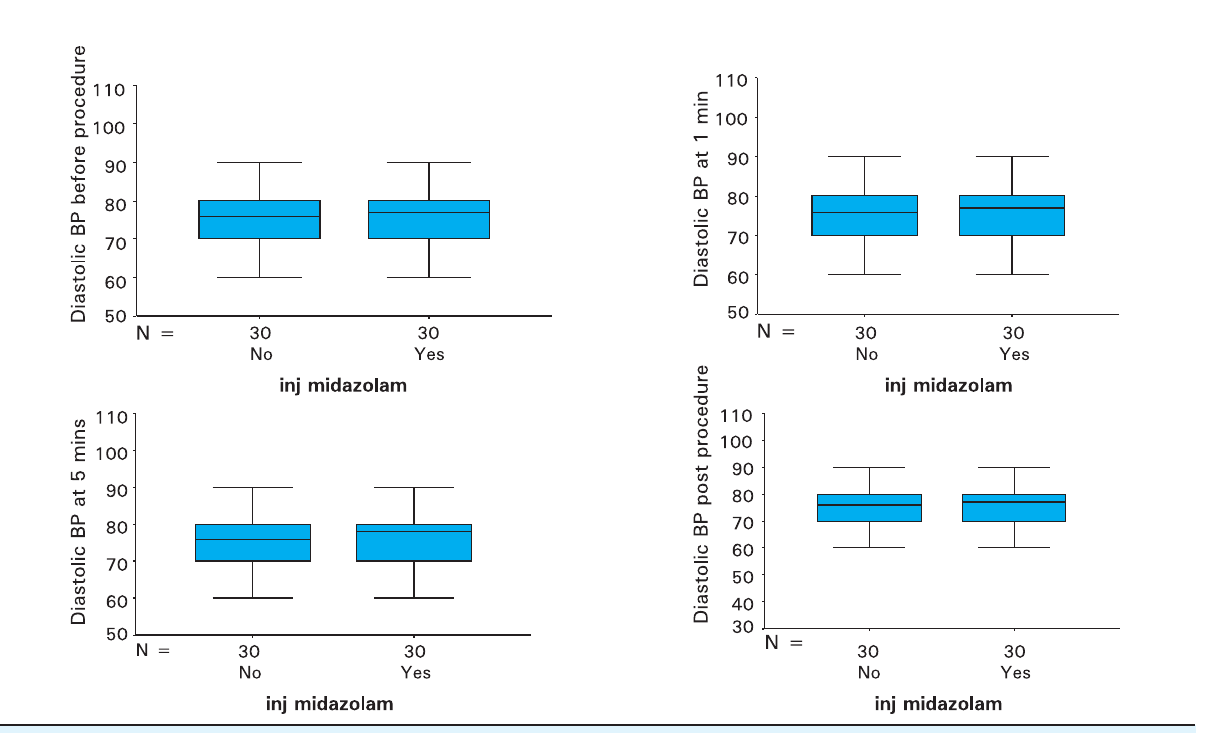
Figure 5. Changes in diastolic blood pressure Since every procedure intervening is associated with signifi cant procedure induced anxiety and discomfort; however as an endoscopist we tend to underestimate patient feeling. In our study 90.6% of patient felt no or slight discomfort where as only 3.6% felt severe discomfort. Similar to our study Brigitte et al found that 68% of sedated patient felt none or slight discomfort while 14 % felt severe discomfort.